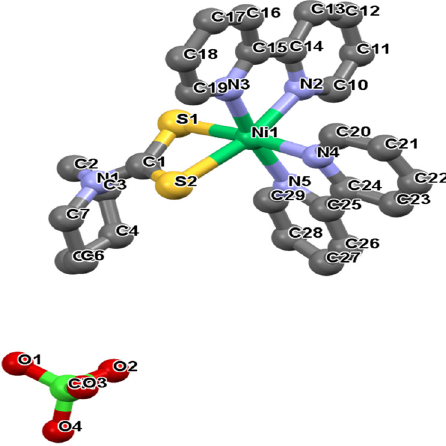
Figure 14: Molecular structure of [ Ni ( hmidtc )( bpy ) 2 ] ClO 4 . Redrawn from ref. [ 54 ] , with permission from Elsevier ( Copyright 2020 ) .